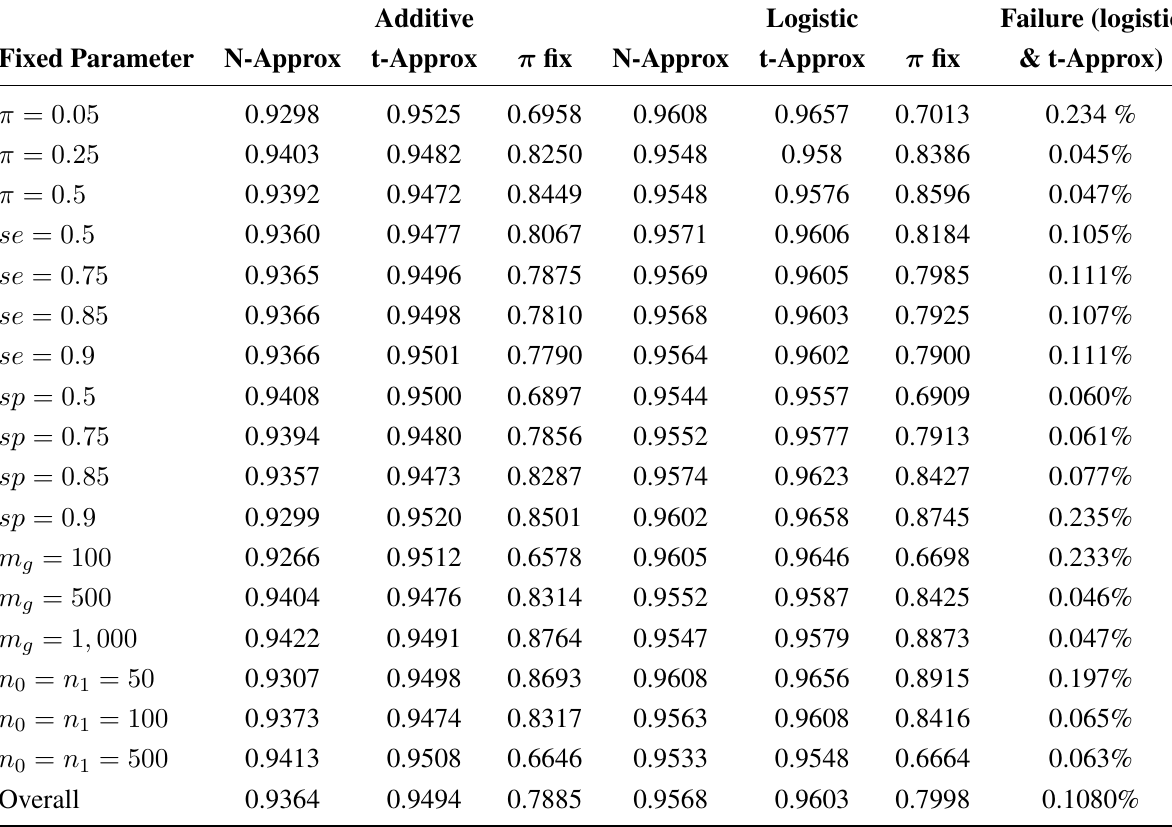
Table 1. Summary of p coverage probabilities where the cell values denote the coverage + probability for one fixed parameter and averaging over the remaining parameters. Hereby N-Approx and t-Approx are abbreviations for normal and t-approximation. π fix denotes the method of [1], where π is assumed to be